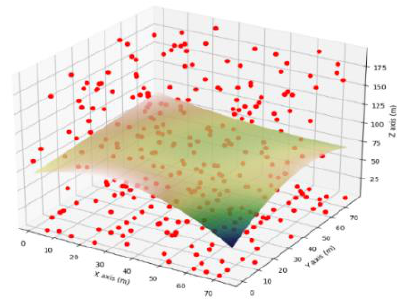
Figure 1. Surface model